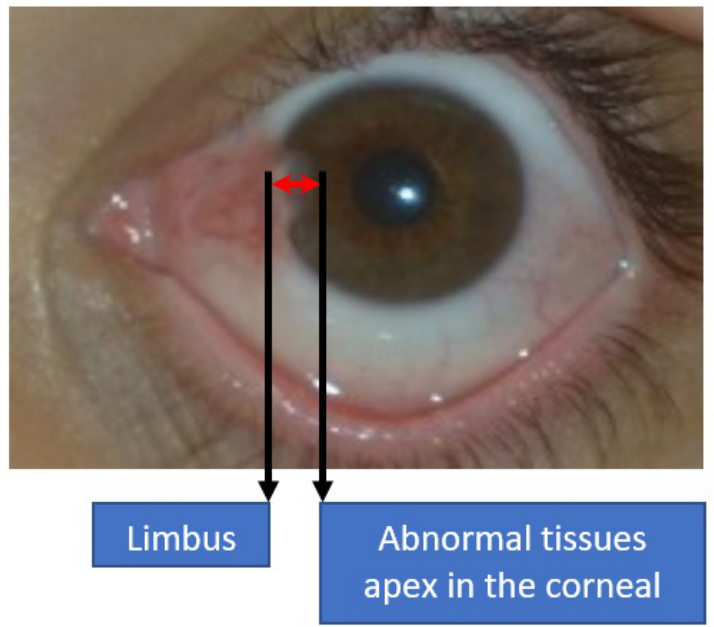
Figure 4. Measurement distance between the limbus and the apex of abnormal tissues in the corneal